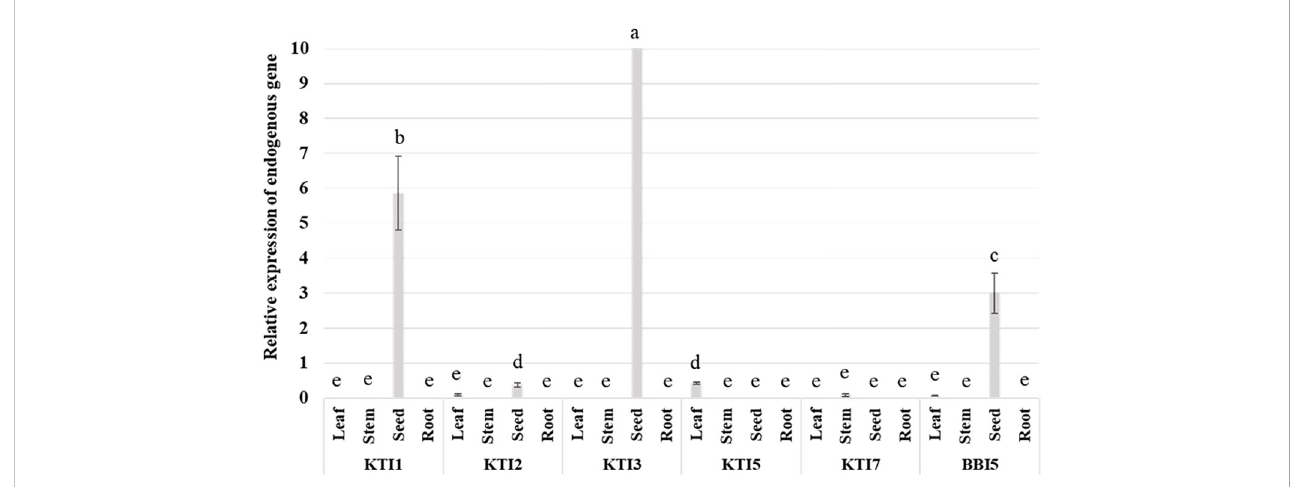
FIGURE 1 Endogenous expression patterns of the individual trypsin inhibitor genes (KTI1, KTI2, KTI3, KTI5, KTI7, BBI5) in different plant tissues of leaves, stems, and roots (six-week-old and seeds (30 days after fl owering) wild-type soybean plants. The relative levels of transcripts were normalized to soybean ubiquitin gene ( GmUBI3 ). Bars represent mean values of six biological replicates (plants) ± standard error. Bars with different letters are signi fi cantly different at p < 0.05 as tested by one-way analysis of variance followed by a Fisher ’ s least signi fi cant